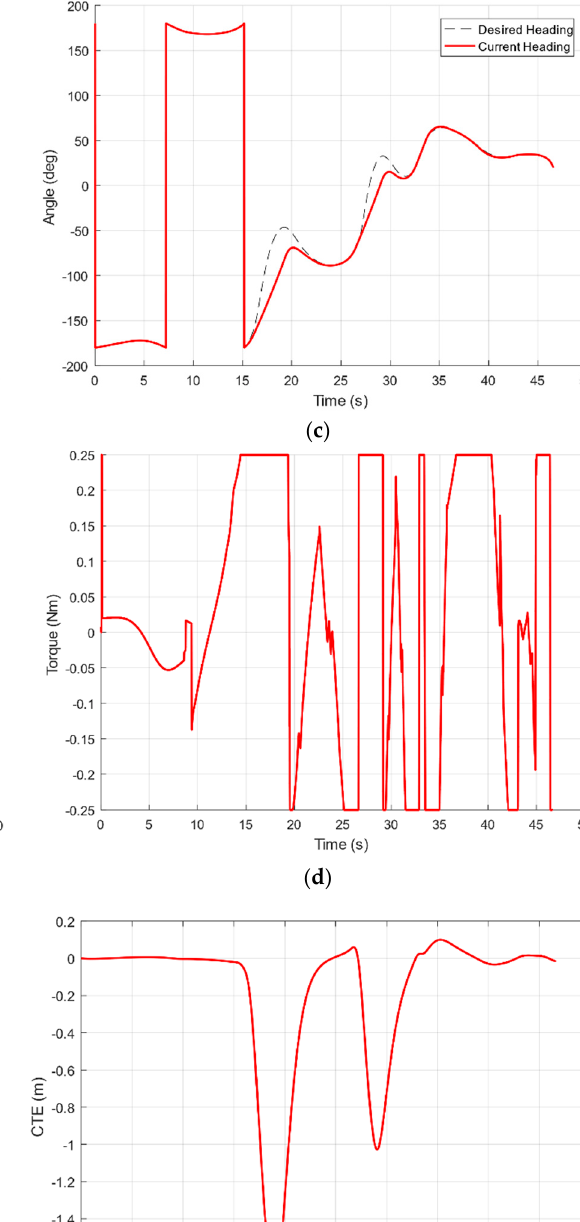
Figure 11. Simulated result of path follower: the traveled path and the corresponding curvature plot in case 1 ( a , b ) and case 2 ( c , d ).